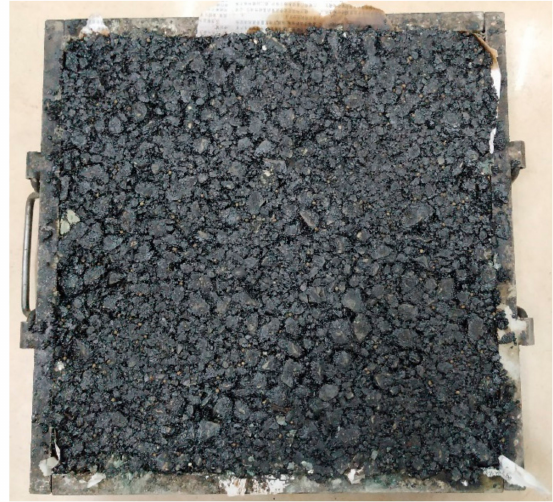
Figure 3. Standard rutting plate